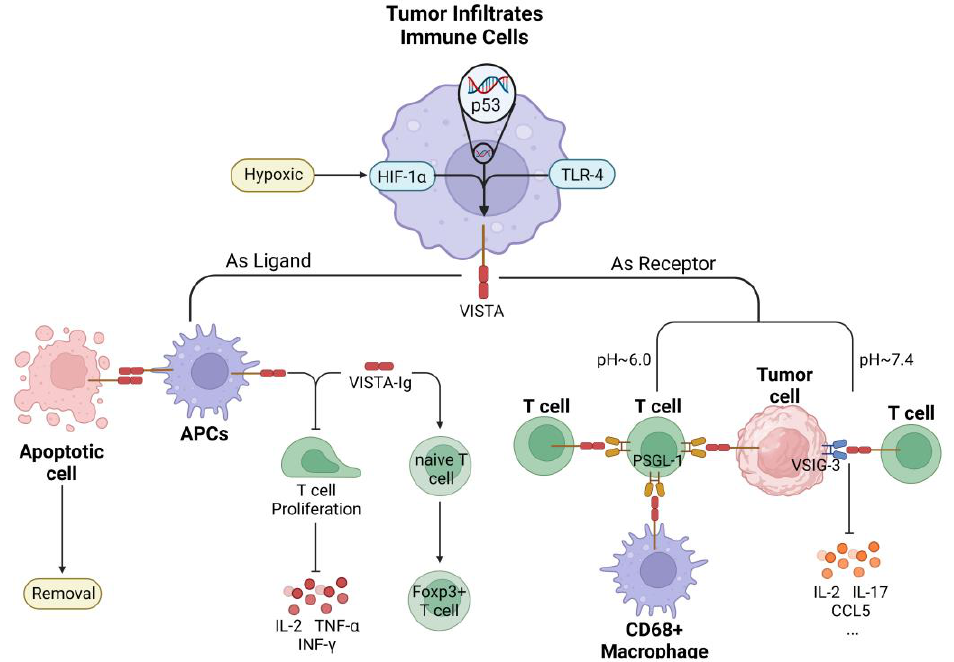
Figure 4. VISTA expression regulation and function in PDAC. VISTA is primarily expressed in tumor- infiltrating immune cells. Hypoxic TME stimulates VISTA expression via upregulation of HIF-1 α , while VISTA is a direct downstream target of reactive p53 molecules. Expression of VISTA may be positively correlated with TLR-4. VISTA can act as a receptor and ligand, binding to several cells and substances in the TME. When serving as a receptor, VISTA binds to the ligand in a pH-dependent manner. VISTA attaches to PSGL-1 on T cells at a pH of about 6.0. When the pH rises to about 7.4, VISTA binds selectively to VSIG-3 on tumor cells, blocking the synthesis of chemicals including IL-2, IL-17, and CCL5. As a ligand, VISTA-Ig greatly increased the conversion of naive T cells into Foxp3+ T cells while suppressing the proliferation of CD4/CD8 T cells, lowering IFN- γ, TNF - α and IL-2 production. The connection between VISTA-VISTA-IgV structural domains on the surface of macrophages and apoptotic cells may facilitate the prompt clearance of apoptotic cells. VISTA is significantly upregulated in immune cells infiltrating the TME of PDAC,